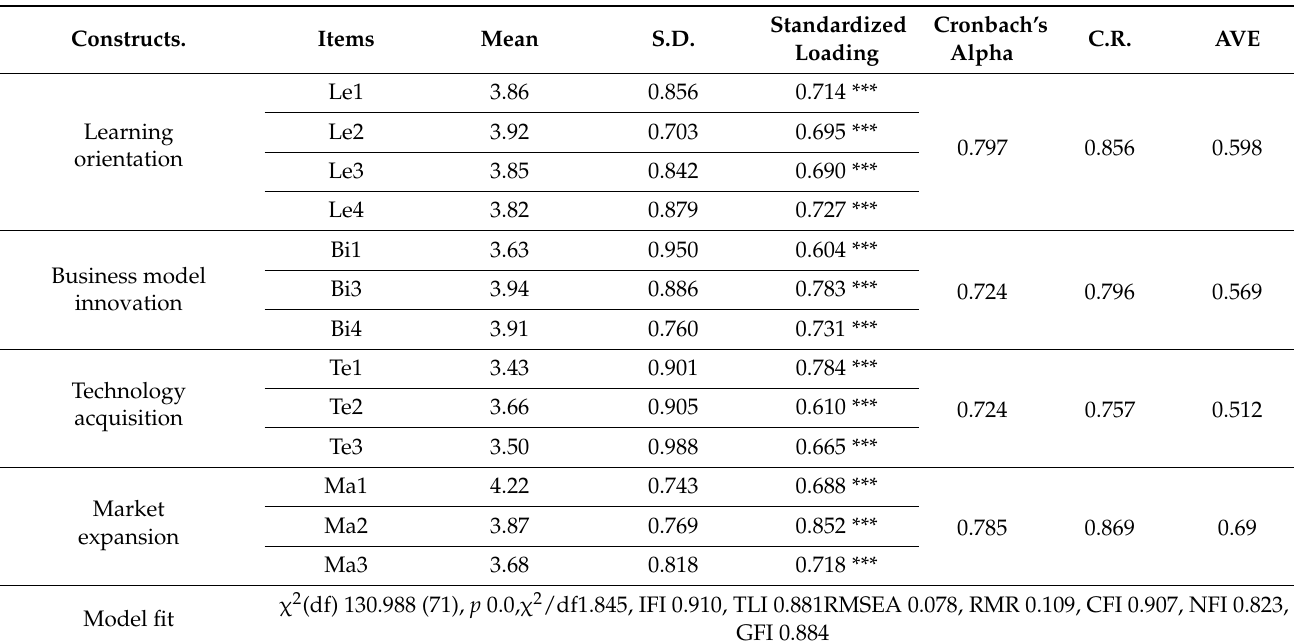
Table 3. Results of reliability and validity analysis.